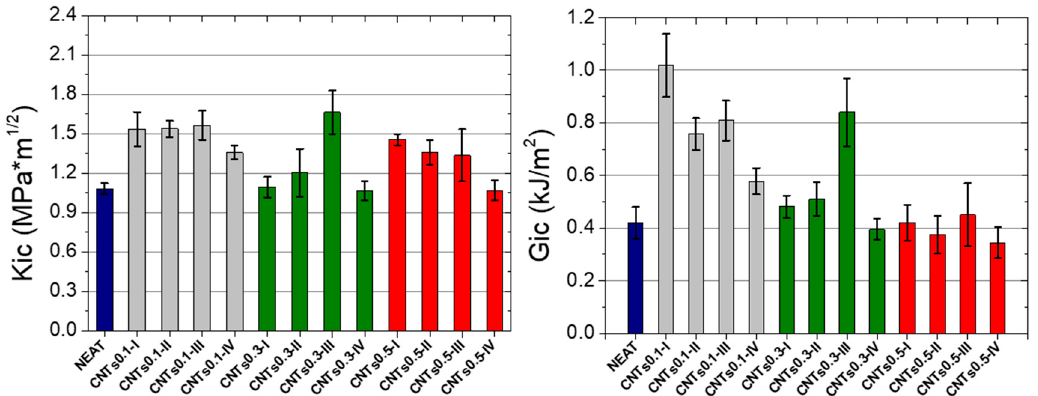
Figure 3. K ic and G ic mean values for specimens with CNTs.